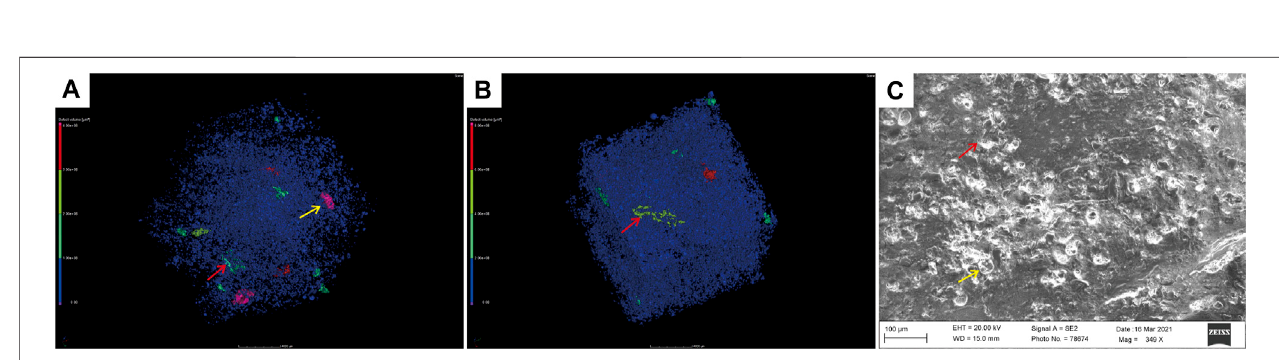
FIGURE 9 | (A) Site W19, 162.80 mbsf, CT scan image; (B) Site W19, 167.10 mbsf, CT scan image; (C) Site W19, 162.80 mbsf, SEM image; red arrows indicate CG-intergranular pores, yellow arrows indicate